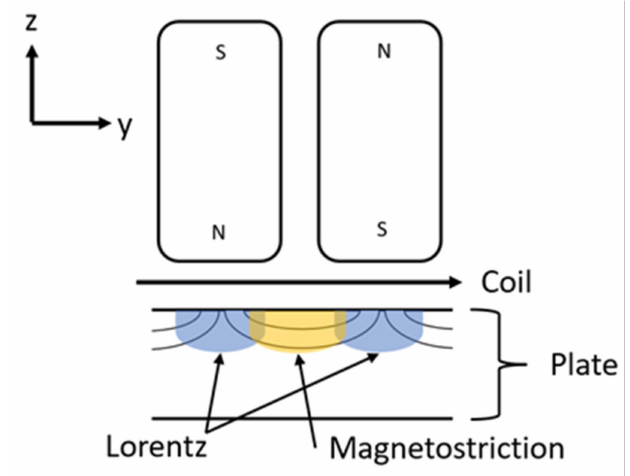
Figure 3. Lorentz and Magnetostriction mechanisms within the PPM EMAT (Side